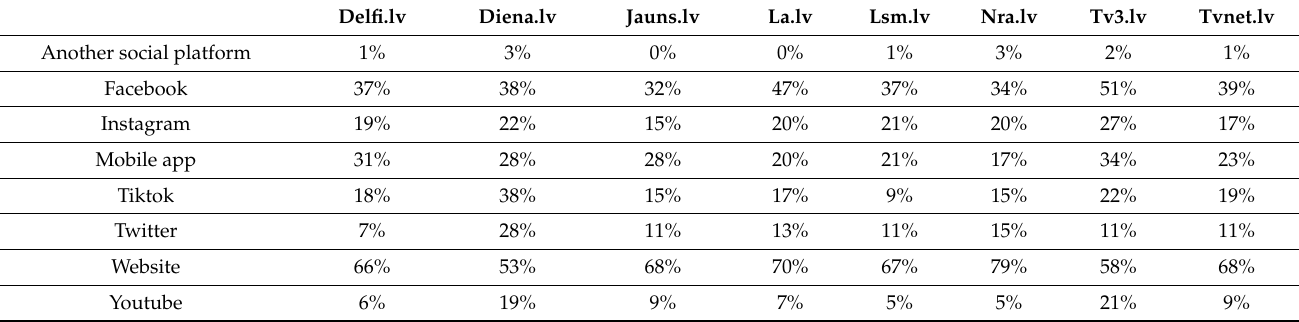
Table 6. Evaluation of news media brand access points among audiences aged 15 to 24 in Latvia in